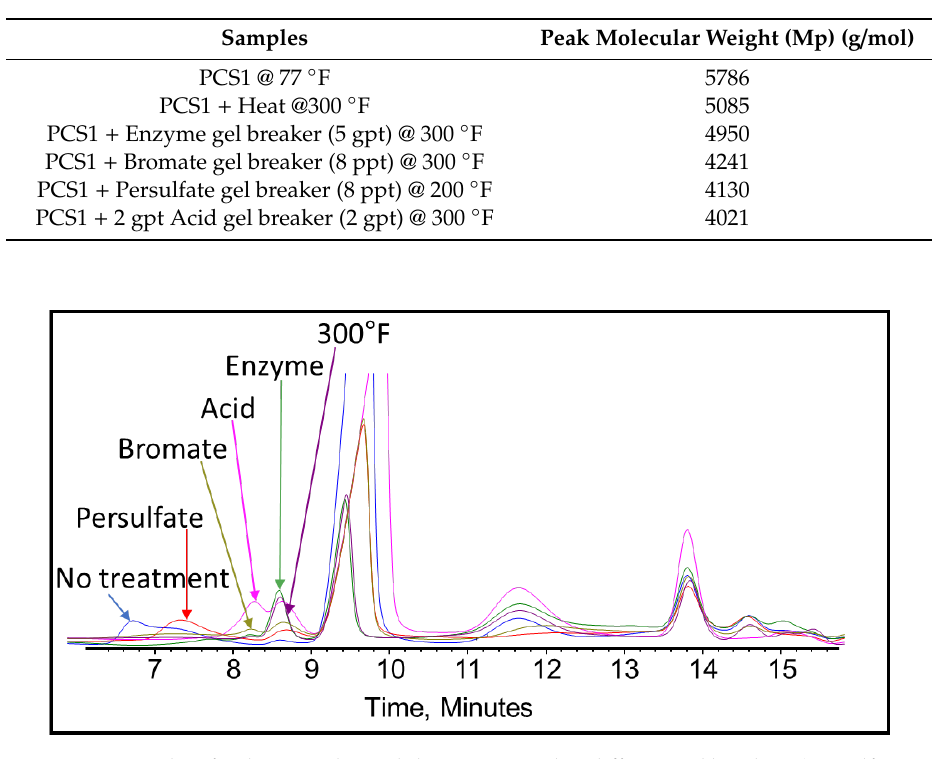
Figure 16. GPC results of polymeric clay stabilizer 2 exposed to di ff erent gel breakers (persulfate: 8 ppt, bromate: 8 ppt, acid: 2 gpt, enzyme: 5 gpt) after 24 h at 200–300 ◦ F. Table 5. Peak molecular weight values of polymeric clay stabilizer 2 with gel breaker samples after 24 h.